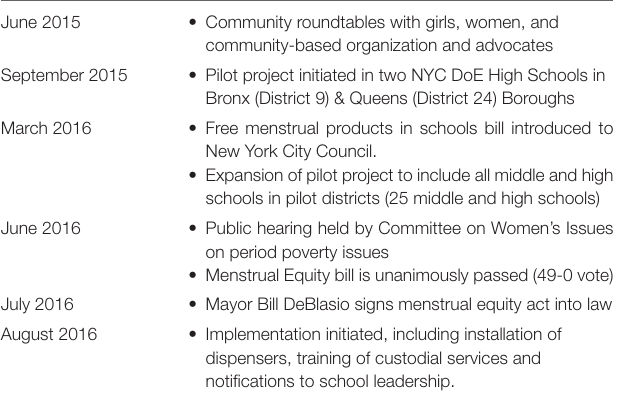
TABLE 1 | Study participants by role. Sector